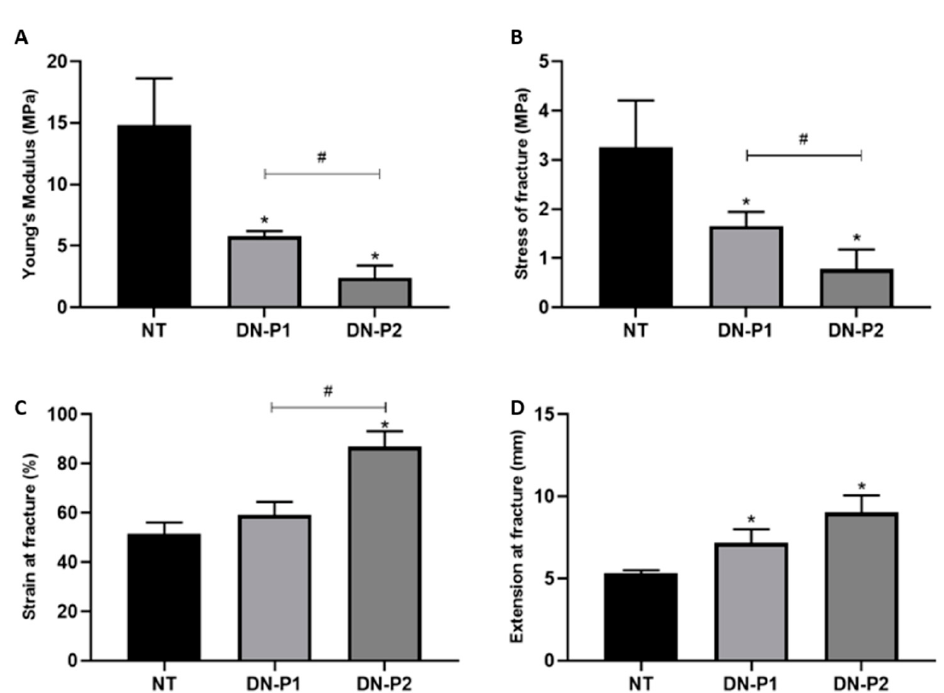
Figure 7. Biomechanical properties of native and decellularized rat sciatic nerves. ( A ) Young’s modulus (MPa), ( B ) failure stress (MPa), ( C ) failure strain (%), and ( D ) elastic modulus (mm). * indicate statistically significant differences ( p < 0.05) of decellularization protocols compared to natives, # indicate statistically significant differences ( p < 0.05) between the two decellularization